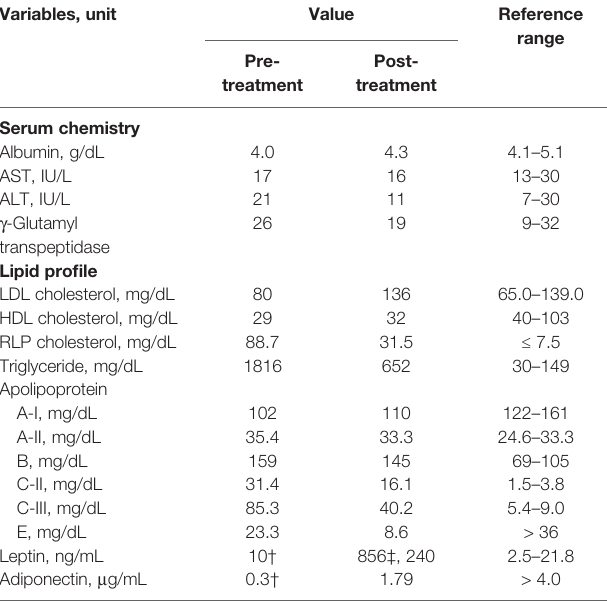
TABLE 2 | Results of laboratory examinations pre- and post-treatment with an SGLT2-inhibitor. Variables, unit